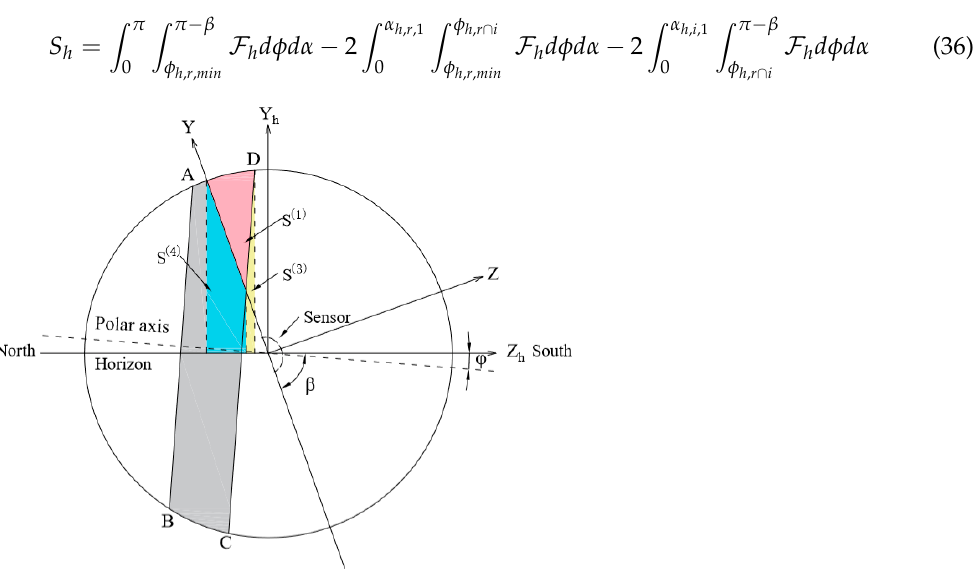
tween the points A and D. The Equation (5) becomes the points A and D. The Equation (5) becomes